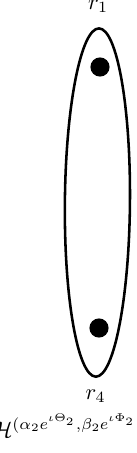
( α 2 e ι Θ 2 , β 2 e ι Φ 2 , γ 2 e ι Ψ 2 ) -level hypergraphs. H